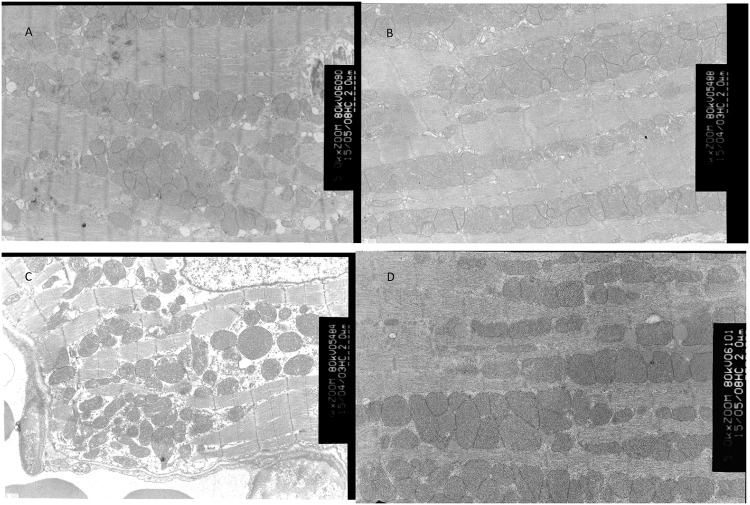
Representative electron microscopy images of cardiac mitochondria of each of the four groups.(A) Control group mice were pretreated with saline and then received saline 5 min later. (B), (C), (D) Mice were pretreated saline, 0.1 mg/kg of isoprenalin or 5 mg of esmolol, respectively, and then received 46.7 mg/kg of bupivacaine 5 min later. Arrows indicate focal high-amplitude matrix swelling.